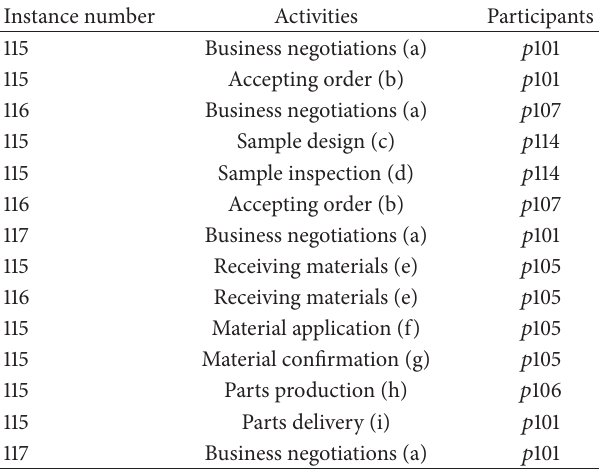
Table 1: The fragment of workflow